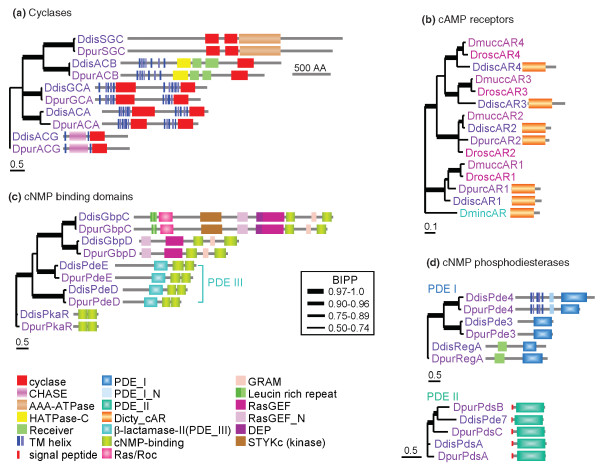
Architectural conservation of cyclic nucleotide signaling genes. Deduced sequences of D. discoideum (Ddis) and D. purpureum (Dpur) proteins were analyzed by SMART [105] for the presence of functional domains, signal peptides and transmembrane helices. To build protein phylogenies, conserved shared functional domains were aligned using CLUSTAL-W [106] and edited when necessary in BioEdit [107] to juxtapose functionally essential amino acid residues. Regions that did not align unambiguously were deleted. For proteins with two similar domains (cyclases and cyclic nucleotide (cNMP) binding proteins), a tandem alignment of both domains was used, with the single domains of ACB and ACG used twice. Phylogenetic relationships between aligned sequences were determined by Bayesian inference [108] using a mixed amino acid model. Rate variation between sites was estimated by a gamma distribution with a proportion of invariable sites. Analyses were run for 100,000 generations or until the standard deviation of split frequences was <0.01. The phylogenetic trees are decorated with the domain architectures of the proteins, except for the D. mucoroides (Dmuc) and D. rosarium (Dros) cAMP receptor (cAR) sequences, which were derived from genes that were only partially amplified by PCR [79]. All trees are unrooted, except for the cAR tree, which is rooted on the single cAR of the group 3 taxon Dictyostelium minutum (Dmin). The posterior probabilities (BIPP) of nodes are represented by line thickness. (a) Cyclases; (b) cAMP receptors; (c) cNMP binding domains; (d) cNMP phosphodiesterases. Dpur protein IDs and, if available, dictyBase IDs: SGC, 153022 (DPU_G0054494); ACB, 154751 (DPU_G0058520); GCA, 151484 (DPU_G0075774); ACA, 51614 (DPU_G0071214); ACG, 38950 (DPU_G0061484); GbpC, 168746; GbpD, 88426 (DPU_G0055716); PdeD, 98774 (DPU_G0059600); PdeE, 56777 (DPU_G0059268); PkaR, 157660 (DPU_G0065616); cAR1, 99295 (DPU_G0064058); cAR2, 92050 (DPU_G0053090); Pde3, 34050 (DPU_G0053756); Pde4, 150656 (DPU_G0073898); PdsA, 98685 (DPU_G0058978); PdsB, 168741 (DPU_G0056384); PdsC, 91767 (DPU_G0073930). GenBank accession numbers for Ddis sequences: ACB, [GenBank:AAD50121]; GCA, [GenBank:CAB42641]; ACA, [GenBank:AAA33163]; ACG, [GenBank:Q03101]; GbpC, [GenBank:AAM34041]; GbpD, [GenBank:AAM34042]; PdeD, [GenBank:AAL06059]; PdeE, [GenBank:AAL06060]; PkaR, [GenBank:P05987]; cAR1, [GenBank:AAA33177]; cAR2, [GenBank:AAB25436]; cAR3, [GenBank:AAB25437]; cAR4, [GenBank:AAB32419]; Pde3, [GenBank:B0G0Y8]; Pde4, [GenBank:AAO59486]; PdsA, [GenBank:XP_637948]; Pde7, [GenBank:EAL62880]. GenBank accession numbers for Dmuc sequences: cAR1, [GenBank:ACF17575]; cAR2, [GenBank:ACF17576]; cAR3, [GenBank:ACF17577]; cAR4, [GenBank:ACF17578]. GenBank accession numbers for Dros sequences: cAR1, [GenBank:AAW24476]; cAR2, [GenBank:AAW24477]; cAR3, [GenBank:ACF17573]; cAR4, [GenBank:ACF17574]. GenBank accession number for Dmin cAR, [GenBank:AAS59250].